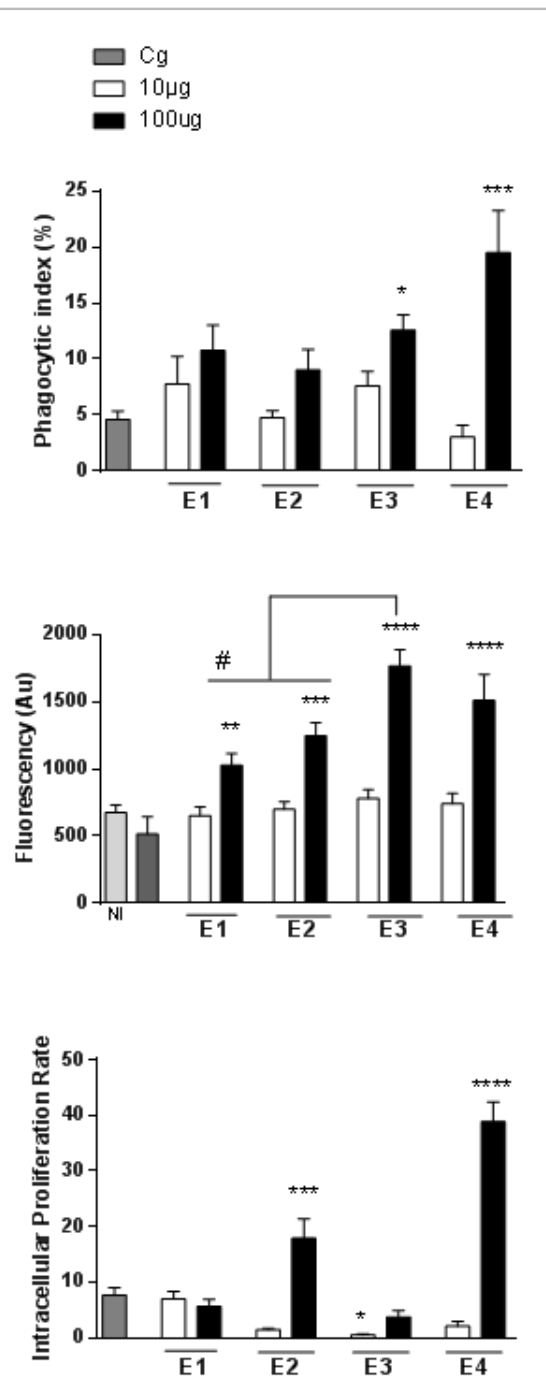
FIGURE 1 - Fungicidal activity from macrophage EP treated against Cryptococcus gattii . (A) Phagocytic index and (B) ROS production by these cells were analyzed 24 hours post infection of cells treated or not with EP dried extract samples at 10 and 100 µg/mL. (C) Fungal intracellular proliferation rate (IPR) was obtained by ratio 24 h/3 h fungal recovery. Bars represent the mean ±SD. *p: were significantly different (p < 0.05), *** (p<0.001), **** (p<0.0001) from Cg infected non treated. # (p<0.05 comparing E2 and E1 vs E3). BMDM (Cg). NI: